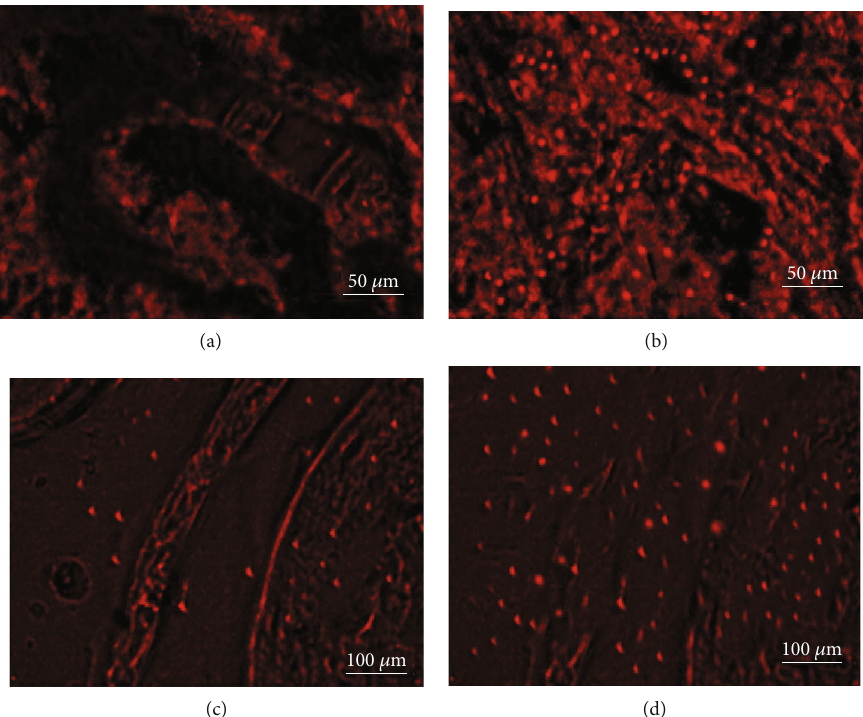
Figure 2: Photomicrograph of sections of retinas shows a positive immuno fl uorescent: (a, c) stem cell group (50 μ m and 100 μ m, respectively) and (b, d) melatonin+stem cell group (50 μ m and 100 μ m, respectively).